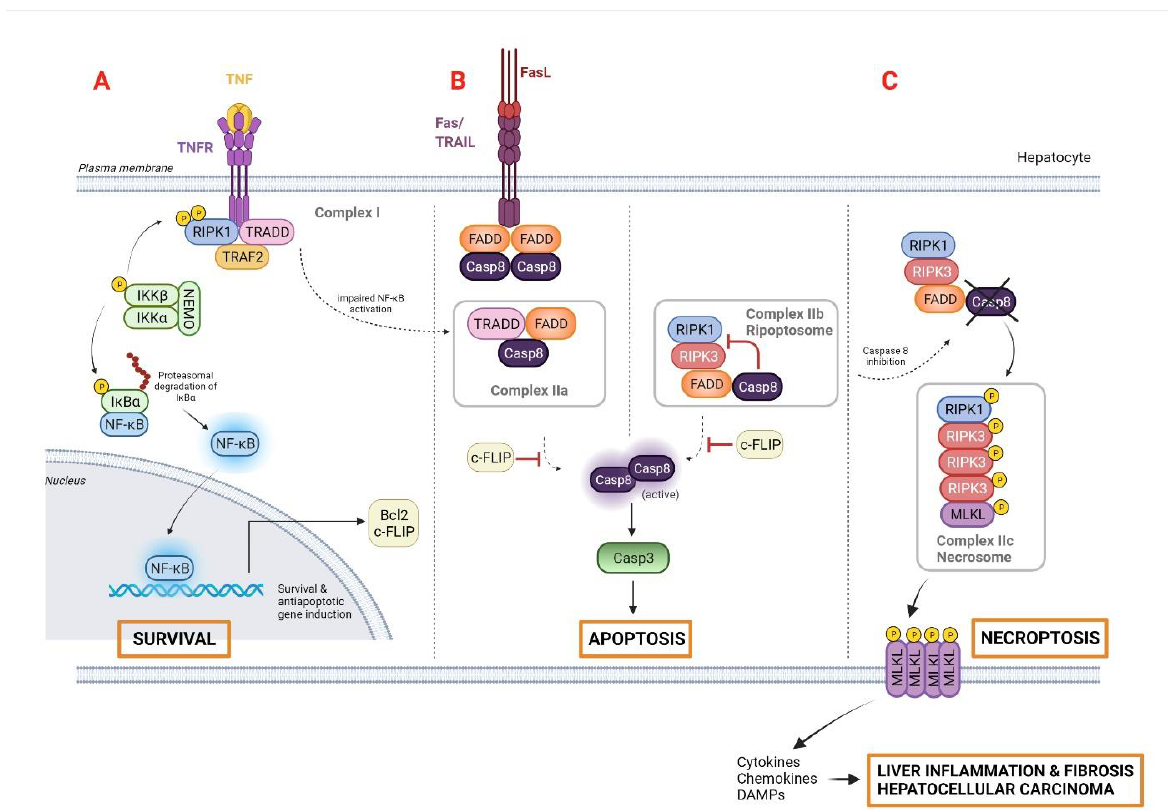
Figure 1. Programmed cell death pathways initiated by TNF and FAS: ( A ) The TNF–TNFR1 cascade simultaneously acti- vates proapoptotic and antiapoptotic signals, and diverse signaling complexes are formed. Complex I, composed by the adaptor protein TRADD, the receptor RIPK1, and the E3 ligase TRAF2, enables the recruitment of the inhibitor NF- ƙ B kinase complex, comprising IKKα/β and NEMO. Subsequently, the inhibitor of NF - ƙ B (I ƙ B α ) is ubiquitinated and NF- ƙ B translocates to the nucleus, promoting the expression of survival and antiapoptotic genes such as Bcl2 and c-FLIP. ( B ) In the FAS/TRAIL-mediated apoptotic pathway, binding of FASL/TRAIL to their cognate receptors results in FAS clustering and binding to FADD. TRADD dissociates from complex I and associates with FADD to form complex IIa, which triggers caspase-8 activation and, consequently, apoptosis. Complex IIb, or ripoptosome, is highly dependent on RIPK1 activity, and represents an alternative death complex that induces apoptosis through direct activation of caspase-8. ( C ) In contrast,